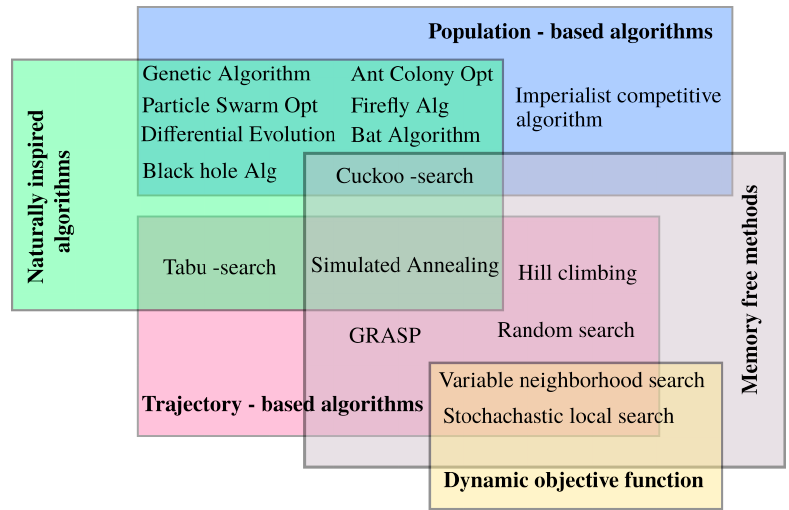
Figure 7. Some selected metaheuristic methods and their